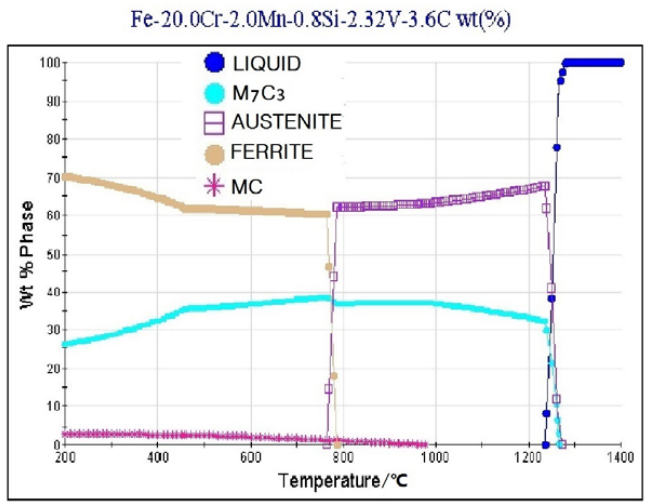
Figure 11. Equilibrium phase mass friction of the 3.6C-20Cr-Fe-2.32V HCCI hardfacing layer.